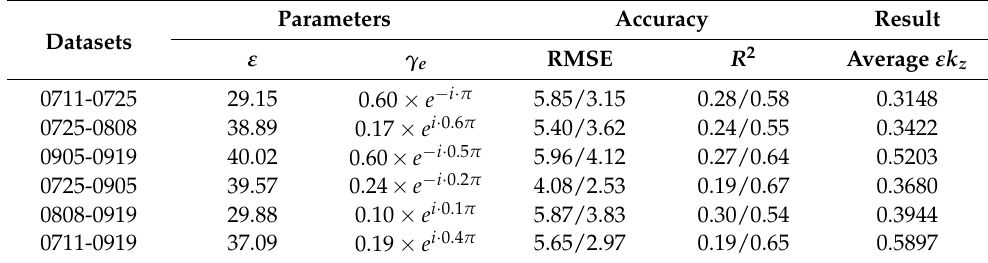
Table 4. Results regarding the parameter iteration and precision of inversion. Both RMSE and R 2 have two values, which are the results of the original model and the improved model,